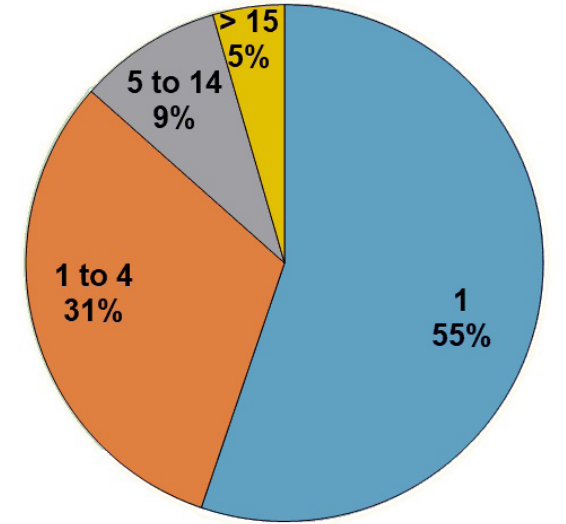
literature references.